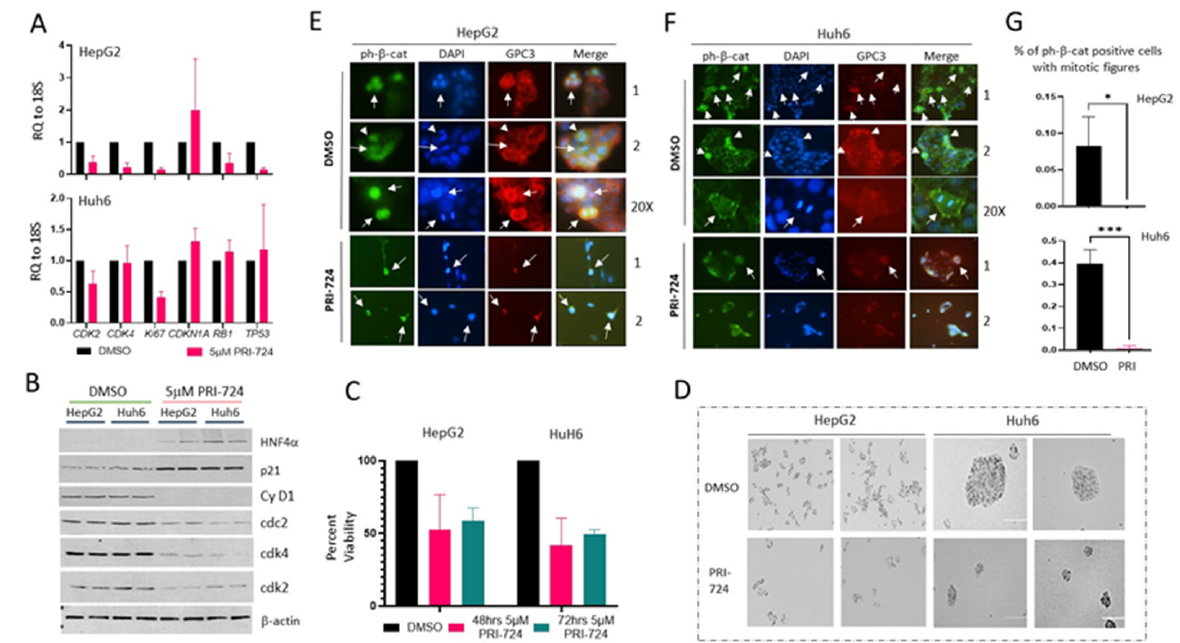
Figure 5. PRI-724 inhibits proliferation of Huh6 and HepG2 cells. ( A ) mRNA levels coding for cell cycle proteins by QRT-PCR. ( B ) Expression of cell cycle proteins determined by Western blot. ( C ) MTT cell proliferation assay with HepG2 (48 h, p = 0.0142; 72 h, p = 0.0258) and Huh6 (48 h, p = 0.0012; 72 h, p = 0.0025) cells treated with DMSO and PRI-724 (one-way ANOVA). ( D ) Images of cells at 72 h after addition of DMSO or PRI-724. Scale bar is 200 µ m. ( E , F ) Huh6 and HepG2 cells treated with DMSO or PRI-724 were examined by IF with antibodies to ph-S675- β -catenin and GPC3 and stained with DAPI. Arrows indicate mitotic figures. ( G ) Calculations of percentage of ph-S675- β -catenin-positive HepG2 and Huh6 with mitotic figures treated with DMSO or PRI-724. Three large (10 × ) fields were counted for each treated cell line (HepG2 p = 0.0219, Huh6 p = 0.0005, unpaired t -tests) (* p ≤ 0.05, *** p ≤ 0.001). The uncropped Western blots have been shown in Figure S9.